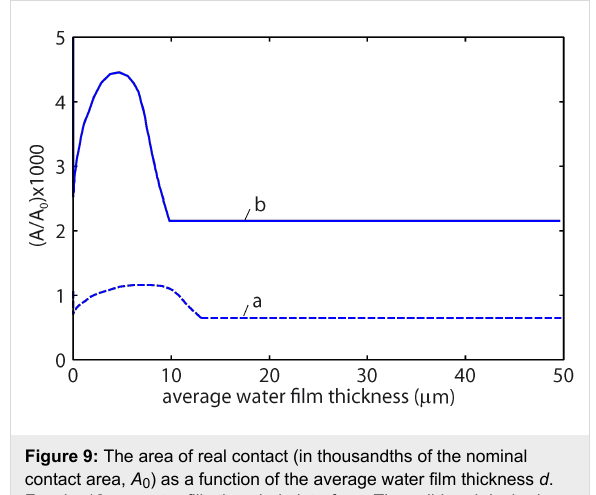
Figure 9: The area of real contact (in thousandths of the nominal contact area, A 0 ) as a function of the average water film thickness d . For d > 12 μ m water fills the whole interface. The solid and dashed curves use the surface power spectra denoted by b and a in Figure 5, respectively. In the calculations we have used the skin model shown in Figure 6 and assumed a contact angle of 0° for water on glass and of 80° for water on skin. The squeezing pressure is p 0 = F N / A 0 = 6.83